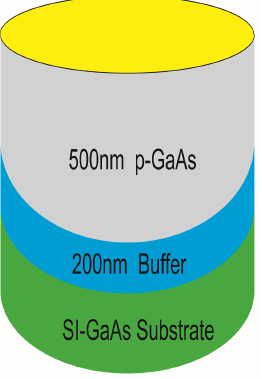
Figure 1. Schematic diagram of sample structure. In polarization optics, the most commonly used polarization direction modulator is the magneto ‐ optical modulator based on the Faraday effect. After linearly polarized light passes through the magneto ‐ optical modulator, its polarization direction changes ac ‐ cording to magnetic induction intensity, and then it is dynamically modulated by the current that generates the magnetic field. Magneto ‐ optical modulators are now widely employed in the fields of biochemistry, pharmaceutical processing, sugar industry man ‐ ufacturing, geometric measurement, and optical modulation technology, achieving highly precise measurement of the optical rotation of living substances, drugs, and sug ‐ ars. Efforts are made to improve the angle measurement and the transmission accuracy of the azimuth, as well as the modulation method of the interferometer. Because the